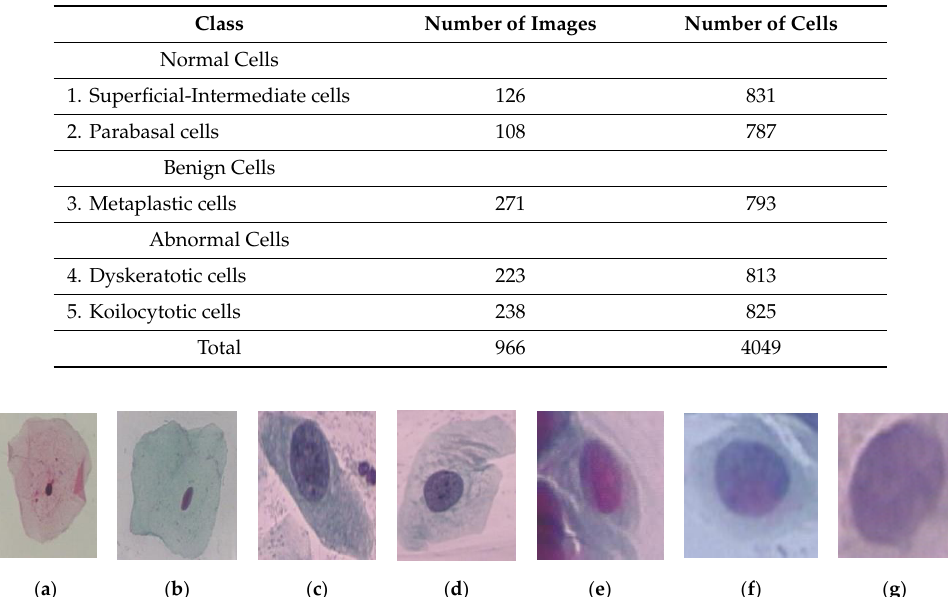
Table 2. Descriptions of five-classes cells from the SIPaKMeD (Multi-cells) dataset.